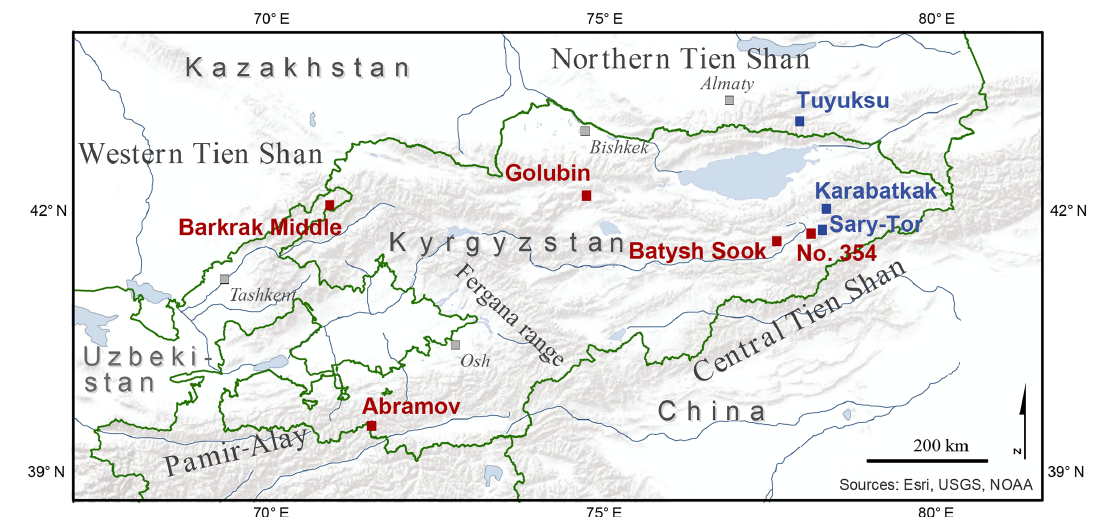
Figure 1. Map of glaciers in Central Asia, where the investigations were gradually re-established starting in 2010. Red symbols show glaciers investigated within the CATCOS and CAWa projects, and blue symbols show glaciers that are covered by other projects such as